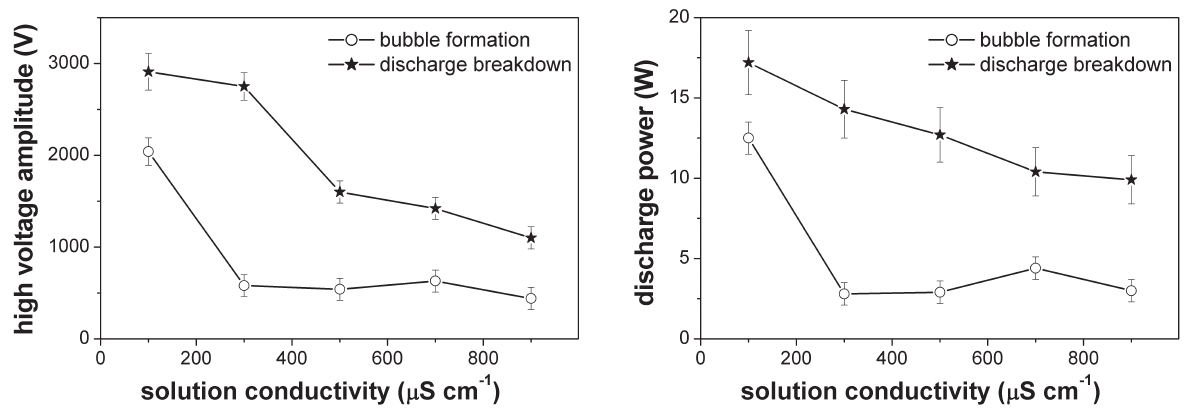
Figure 4: Minimal applied high voltage amplitude (left) and discharge power (right) of bubble formation and discharge breakdown as a function of solution conductivity; NaCl solution, dielectric barrier thickness of 0.6 mm, pin-hole diameter of 0.6 mm.